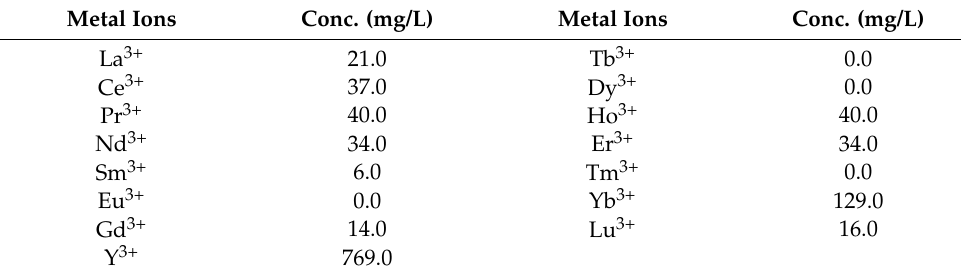
Table 7. Chemical investigation of RE ions in the leach